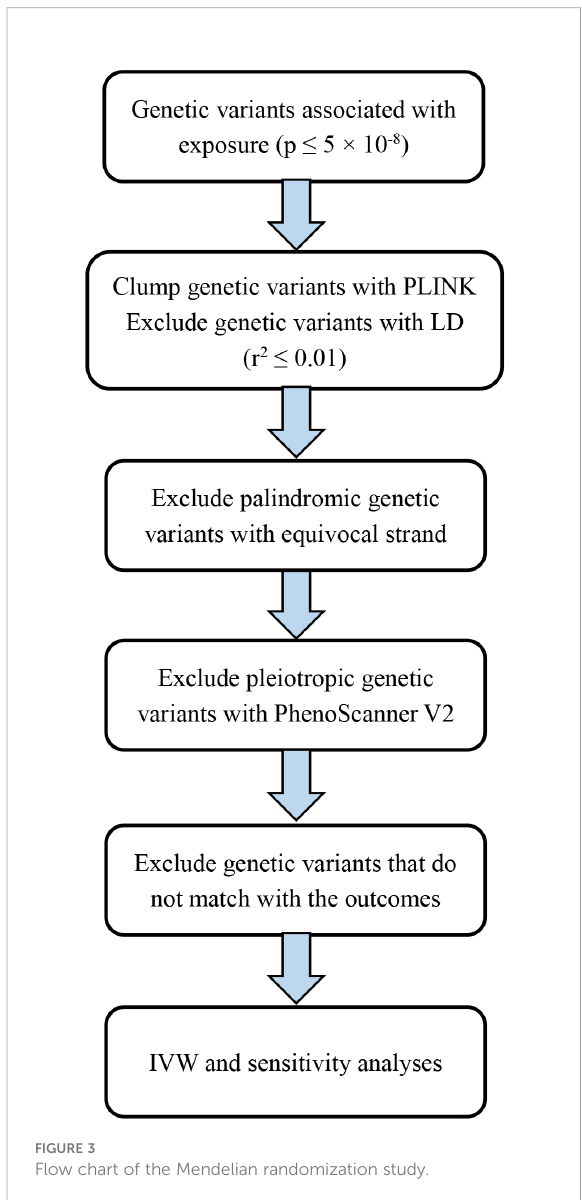
FIGURE 3 Flow chart of the Mendelian randomization